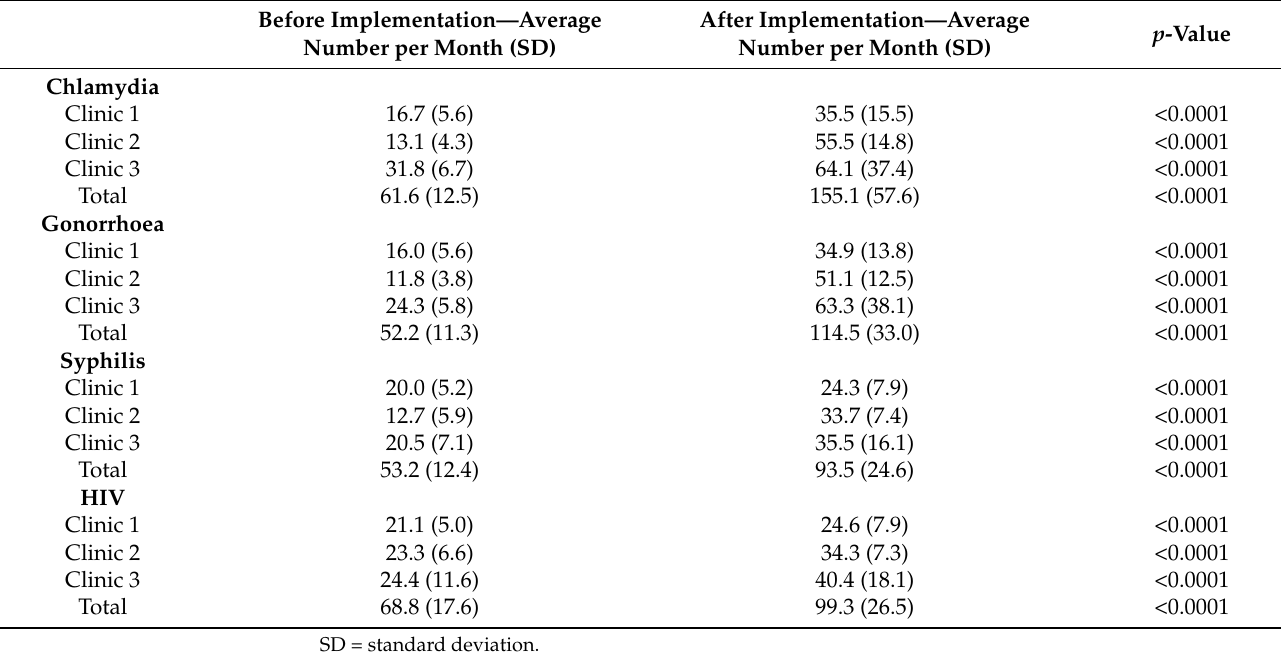
Table 1. The average number of HIV/STI tests.